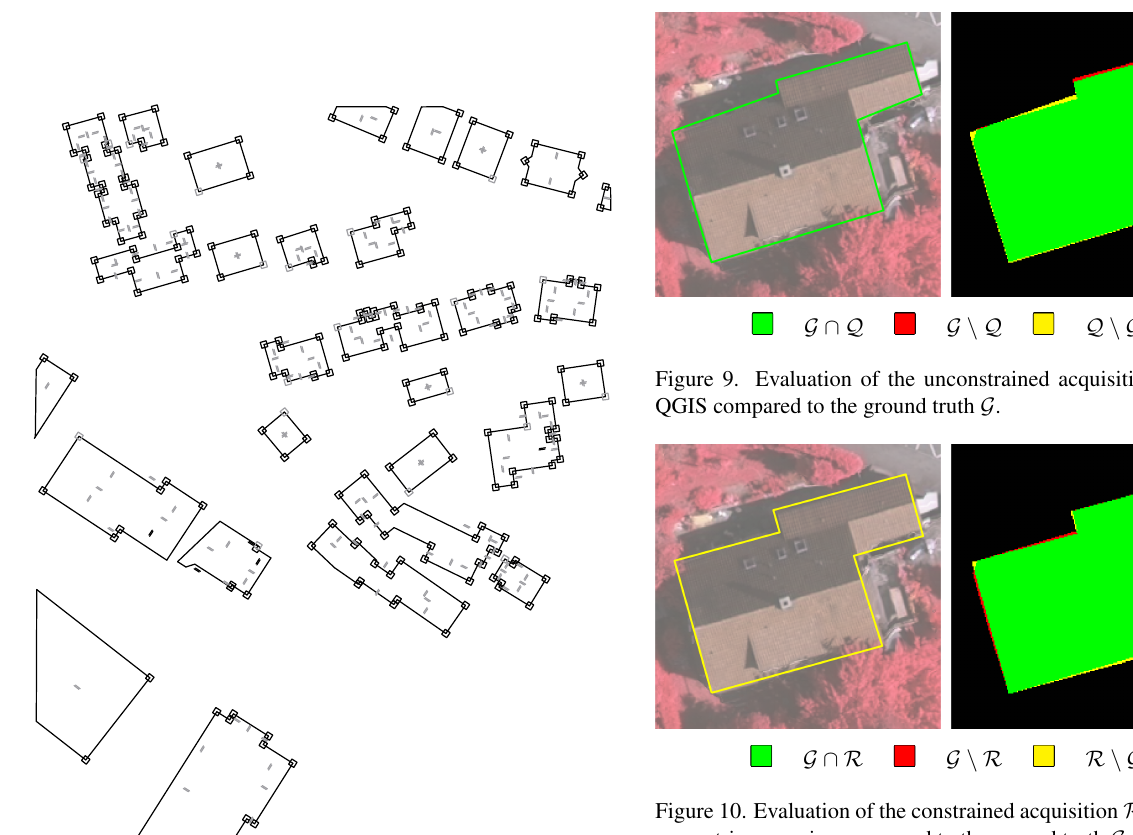
Figure 10. Evaluation of the constrained acquisition R guided by geometric reasoning compared to the ground truth G .